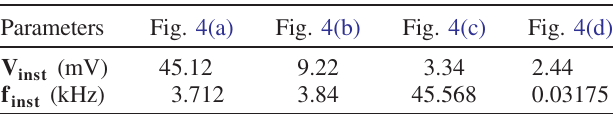
TABLE II. Plasma instabilities parameters of various cases with respect to Fig.